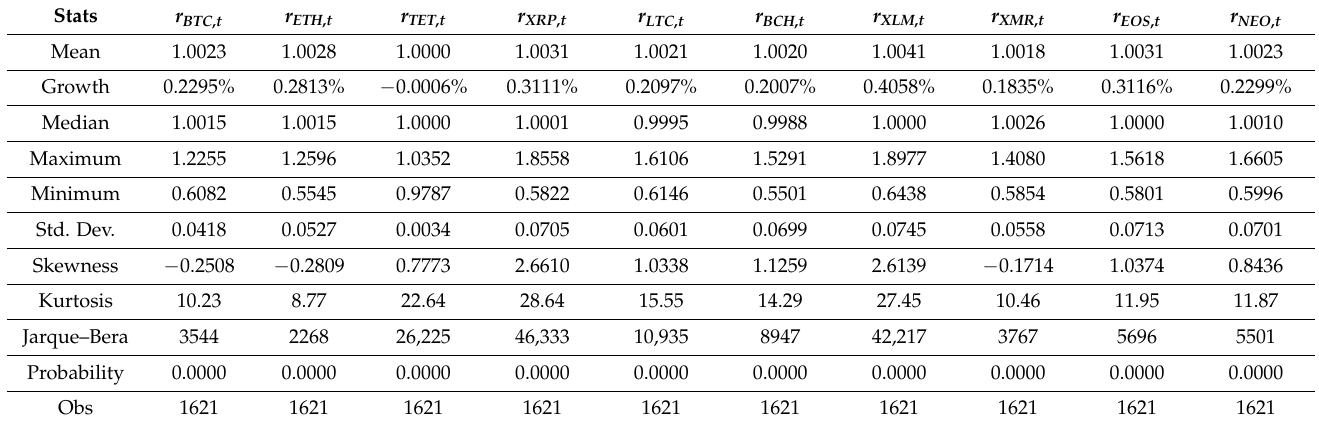
Table 2. Descriptive statistics of the 10 cryptocurrencies’ return indices for the full